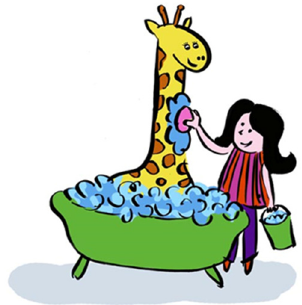
Figure A1. An example of a picture used in the sentence-picture matching task.